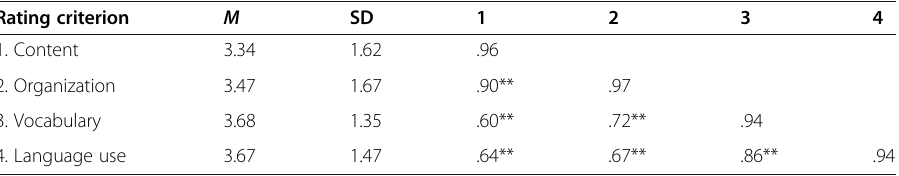
Table 7 Correlations for novice ratings (standard) Rating criterion